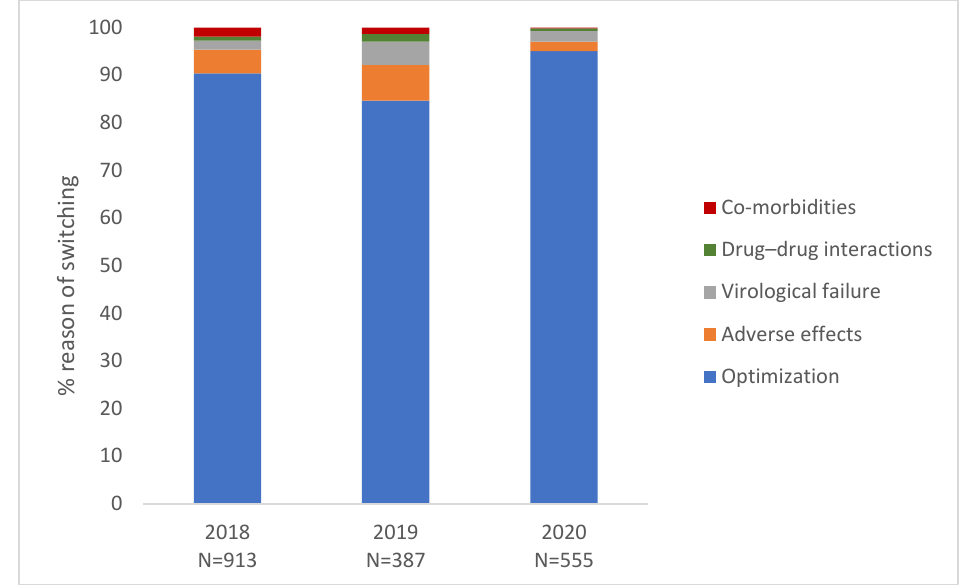
Figure 2. Reason for switching by year (2018–2020). Table 3. Switching matrix for ART drug class (2018–2020).